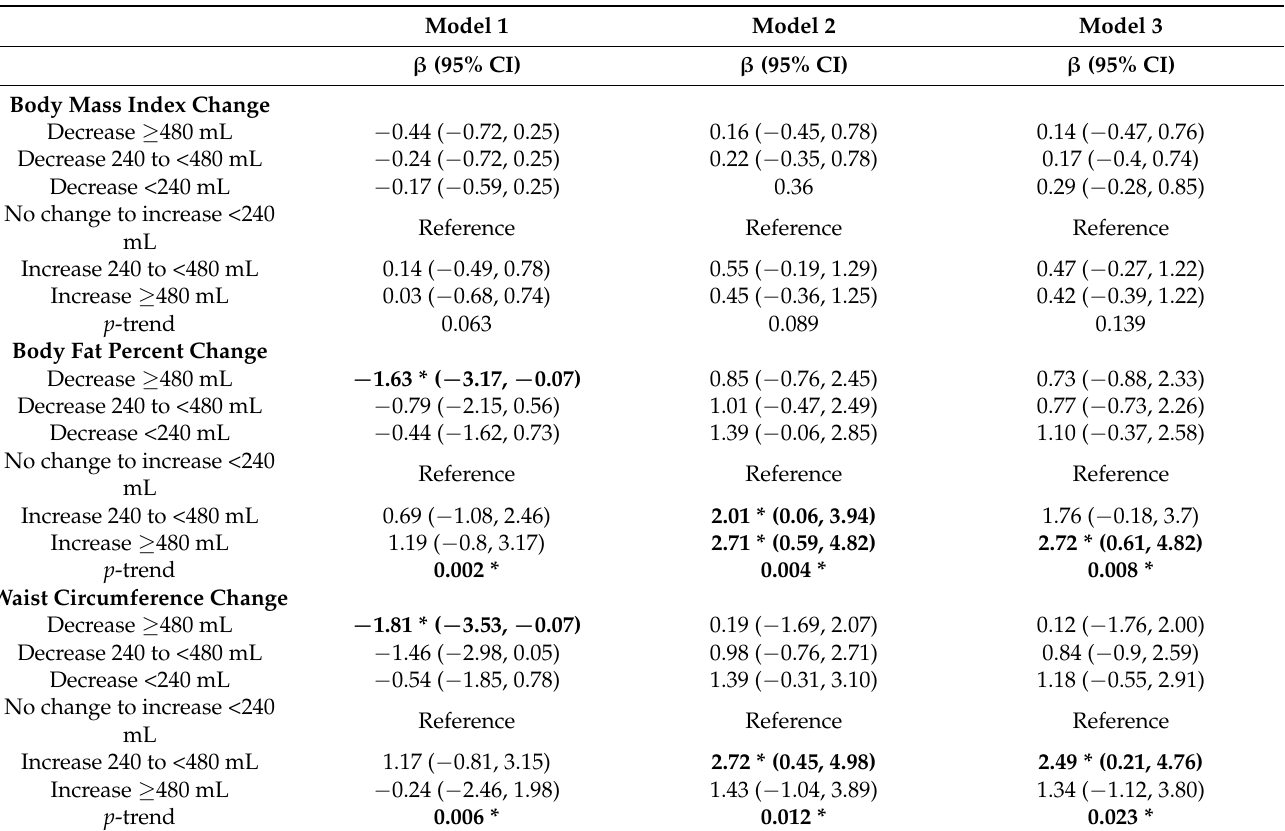
Table 3. Linear regression models between beverage consumption change and body composition changes from 2015 to 2017 ( n =